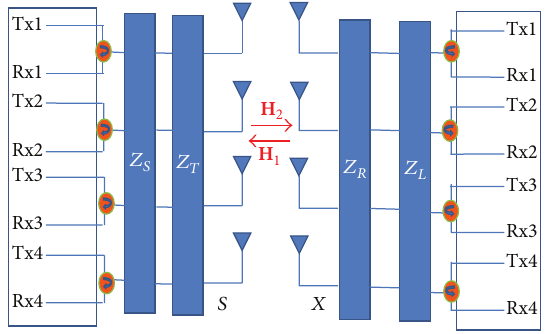
Figure 6: 4 × 4 MIMO system with mutual-coupling